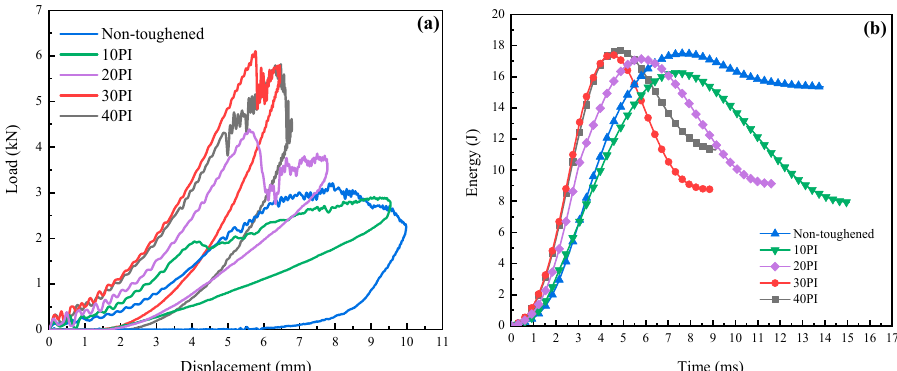
Figure 7. Effect of areal densities of PI interleave on the impact properties of composite laminates: ( a ) load–displacement curves, ( b ) energy–time curves. Table 1. Parameters obtained from low velocity impact tests.